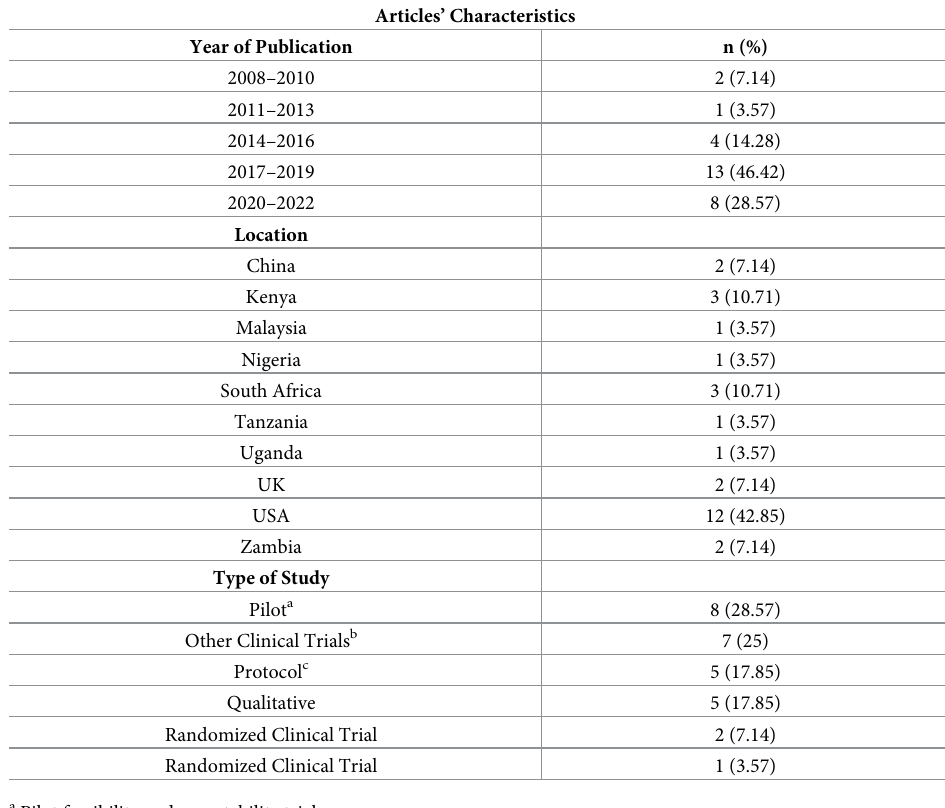
Table 1. Characterization of included